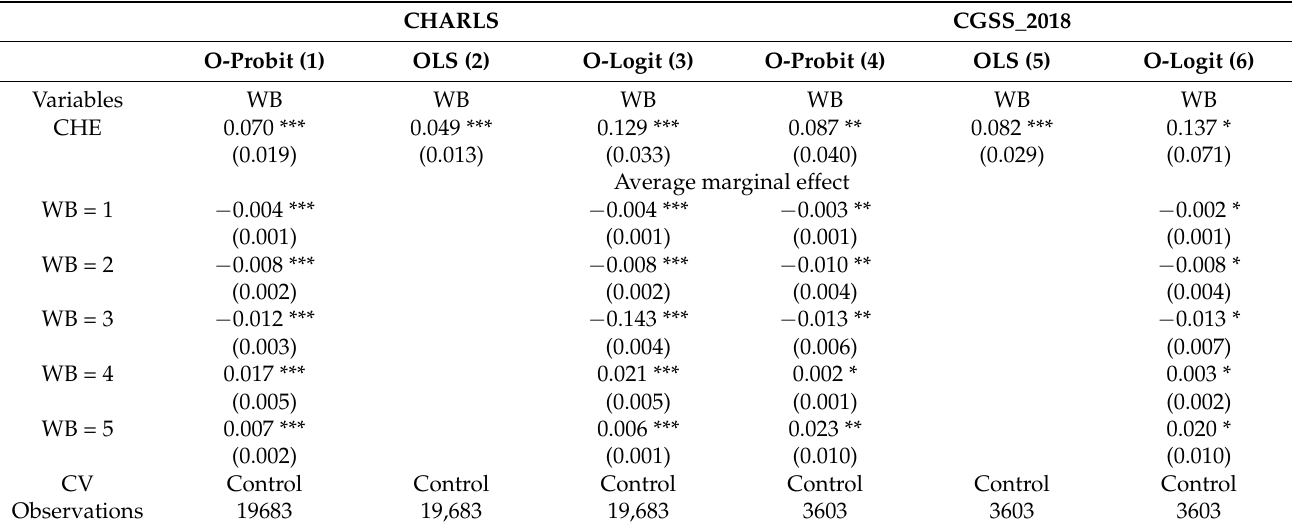
Table 4. Robustness test results for replacement sample data and